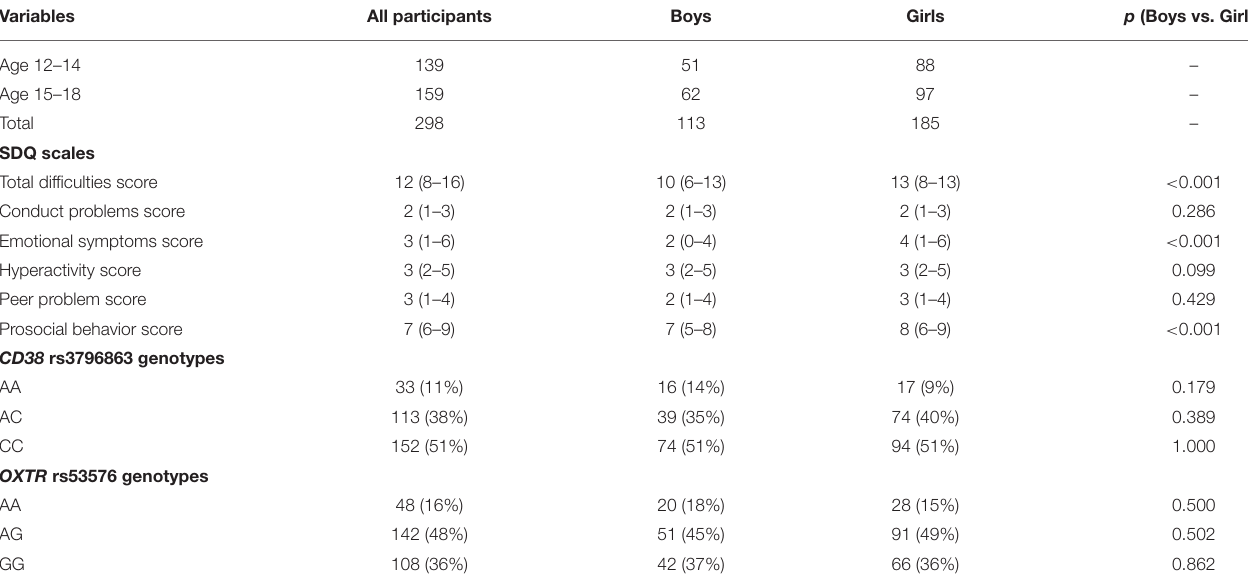
TABLE 1 | Descriptive statistics for major study variables, SDQ scales, CD38 rs3796863, and OXTR rs53576. Variables